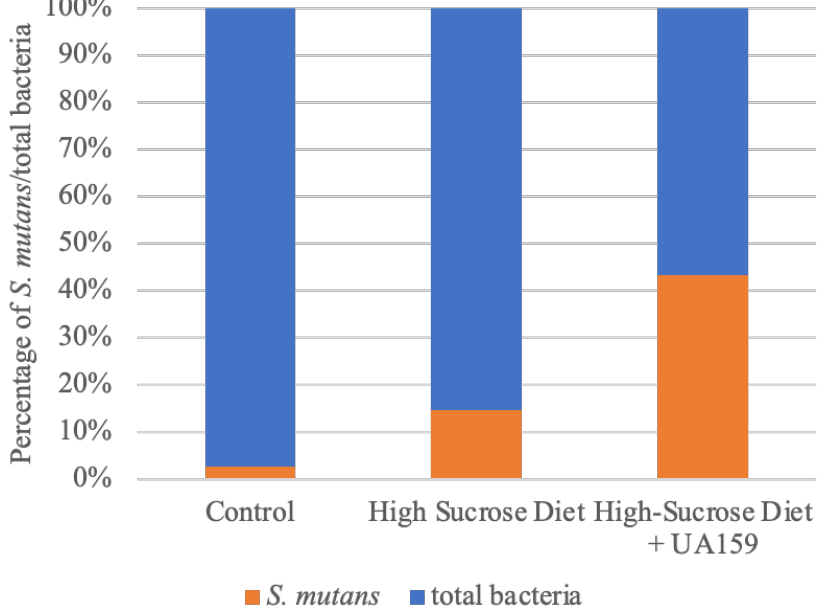
Figure 9. Cariogenic diet and bacterial infection increase the relative percentage of S. mutans from total bacterial counts in the mice oral habitat. Cariogenic (high-sucrose) diet and bacterial infections induced a significant increase of S. mutans bacterial load. The results are presented as percentages normalized to the total bacterial count in each group. Blue = total bacteria viable count. Orange = S. mutans viable count.